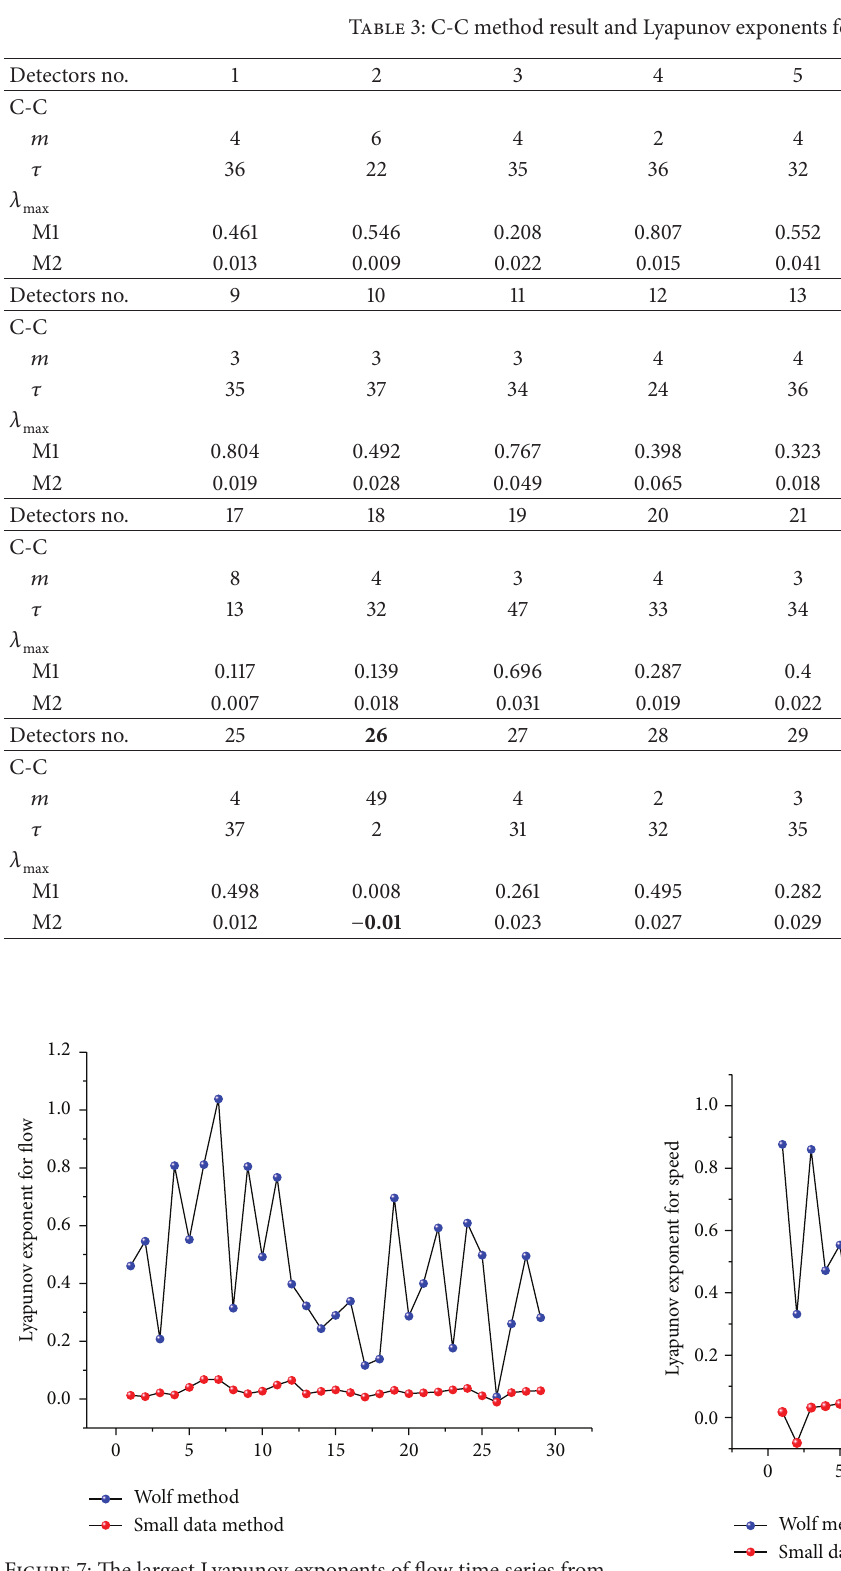
Figure 8: The largest Lyapunov exponents of speed time series from 29 detectors. Values are positive except those at the 14th detector by Wolf method, and values at the 2nd and 17th detectors are negative by small data sets